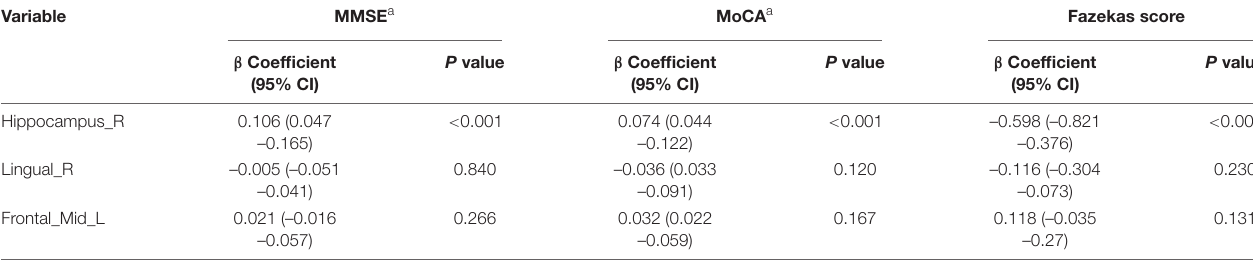
TABLE 3 | Correlation between DC values and clinical implications in CAD patients.